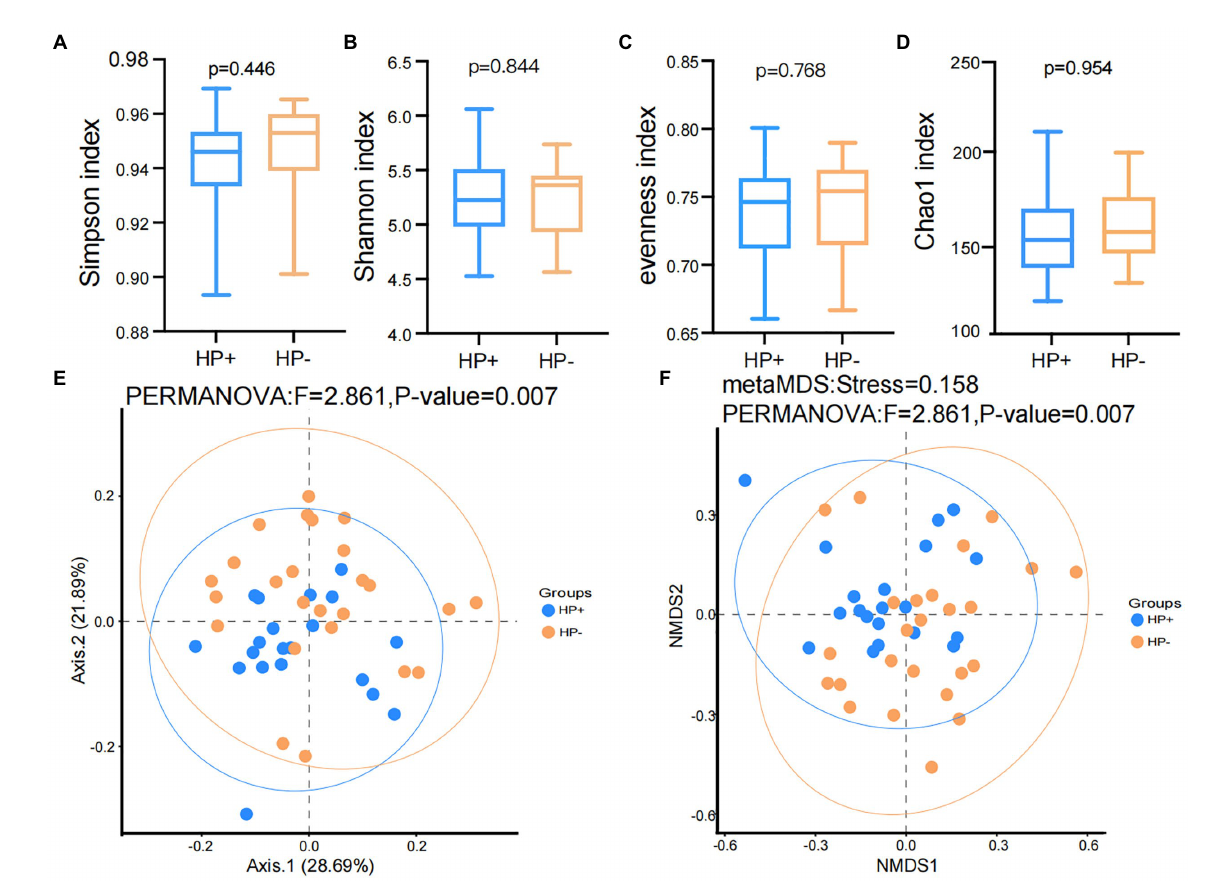
FIGURE 1 Comparison of Alpha and beta diversities between HP − and HP+ PCG. (A) Simpson index. (B) Shannon index. (C) Eveness index. (D) Chao1 index. (E) PCoA based on Bray-Curtis distances. (F) NMDS on Bray-Curtis